Question: Looking at the figure, what chart type is it?
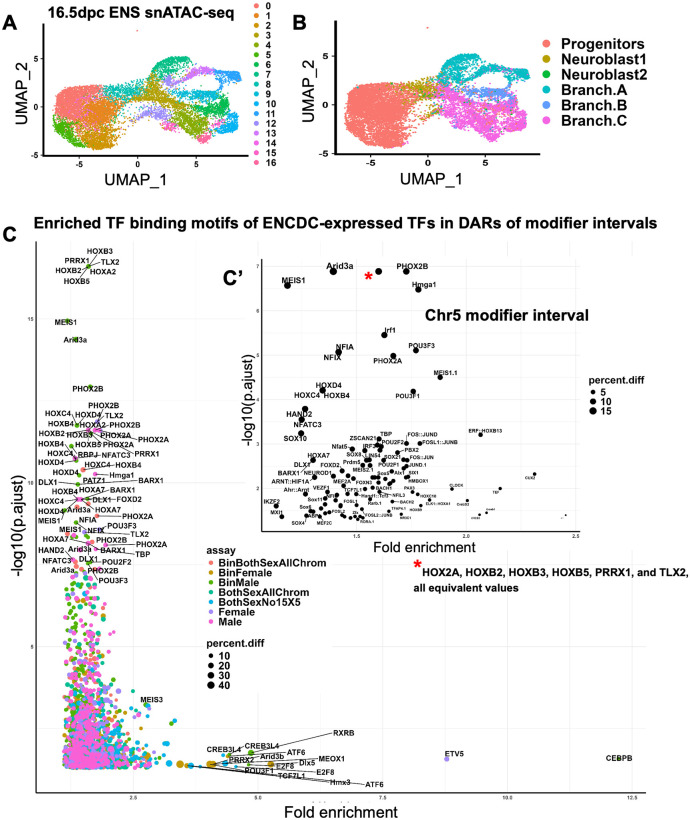
Answer: scatter